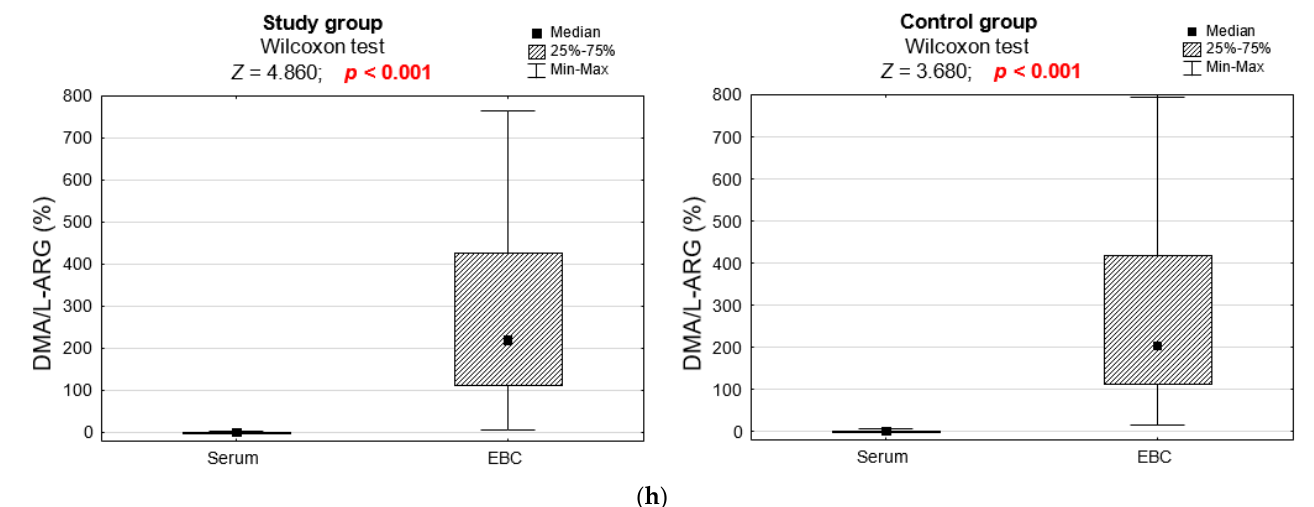
Figure 1. ( a – h ) Comparison of the concentrations of L-ARG and its metabolites in serum and EBC between study group and control group. The significance of differences in the assessment of L-ARG and its metabolites in serum and EBC of asthmatic and non-asthmatic subjects was verified using the Wilcoxon test.